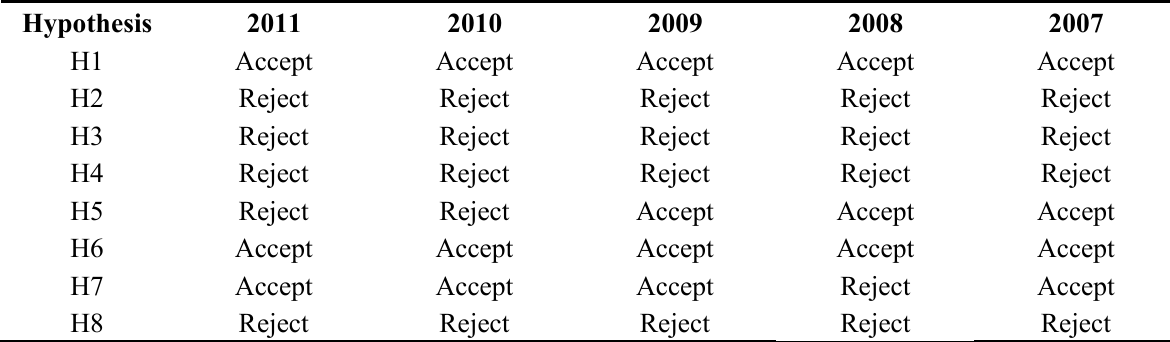
Table 6. Results of